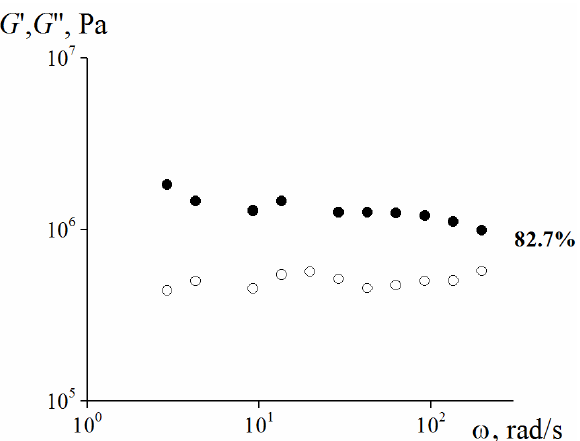
Figure 5. Frequency dependence (at γ = 0.001) of the storage modulus for 82.7 vol. % Scheme 25. content of smaller particles and λ = 2.4 (the storage modulus is marked by dark symbols, the loss modulus—by light ones).